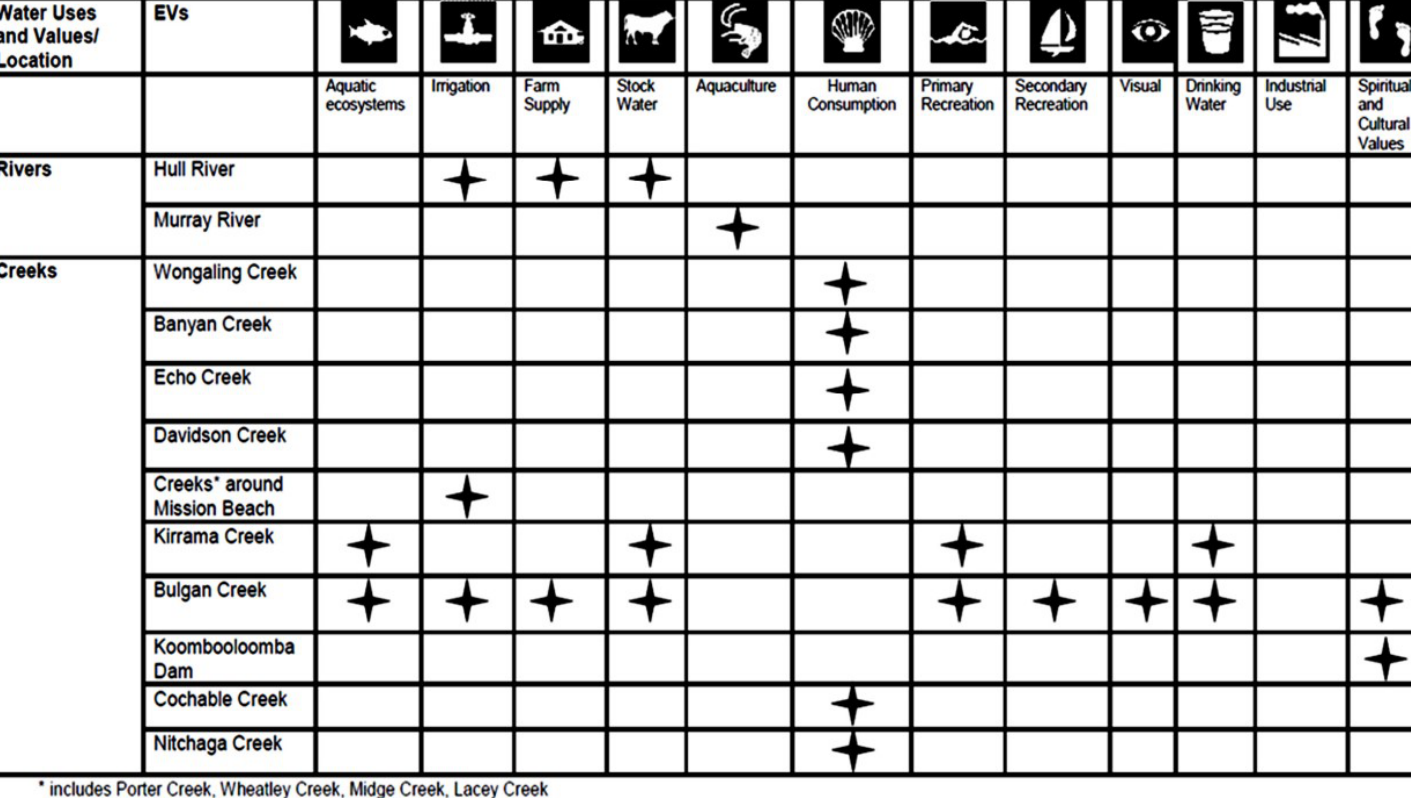
Figure A5. Additional environmental values (EVs) to be added to the Tully EV list. + This table only includes the additional EVs identified by interviewees that can be categorised in the State of Queensland’s Guidelines’ Suite of EVs.